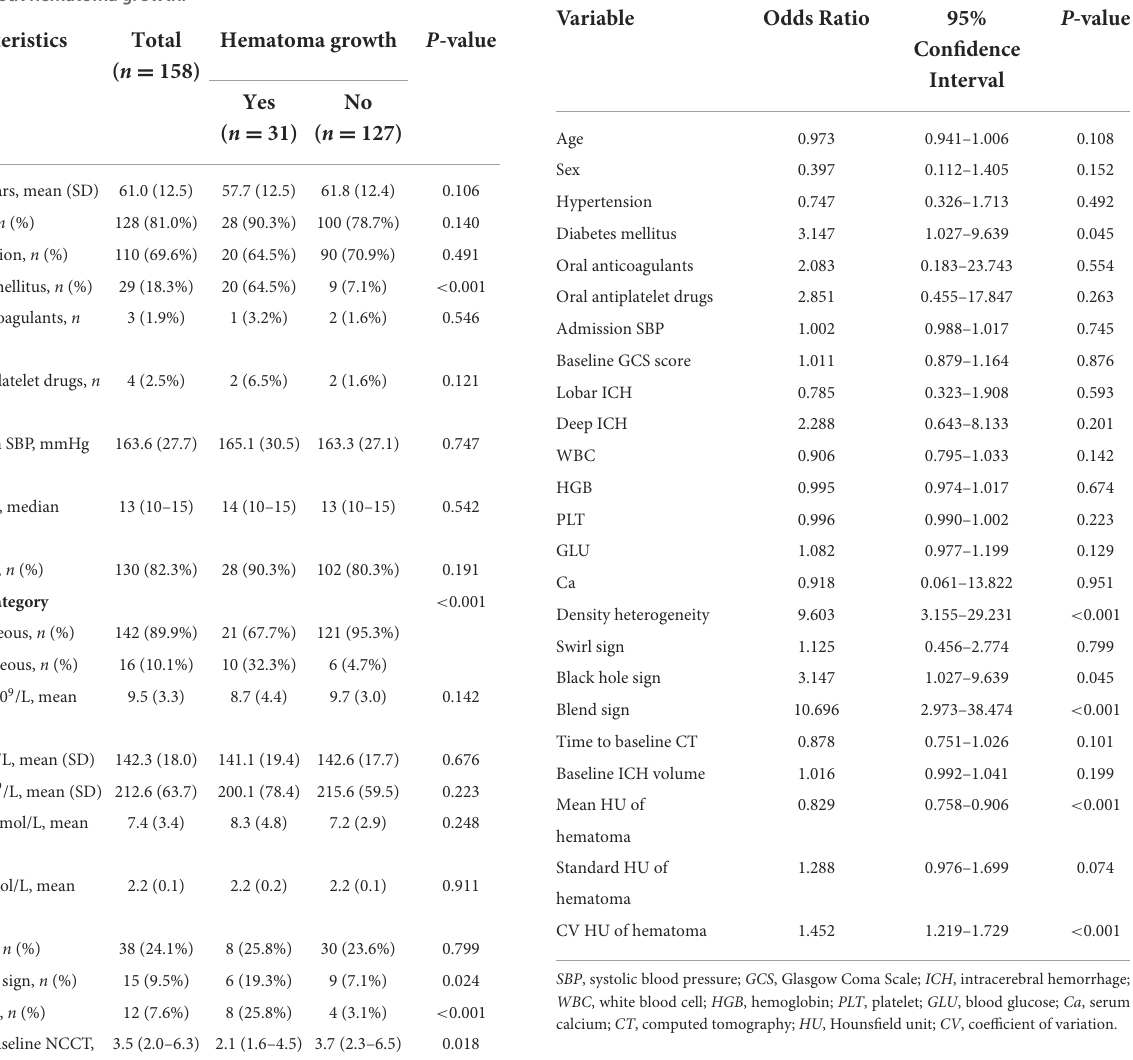
TABLE 1 Clinical and radiological baseline features of individuals with and without hematoma growth.